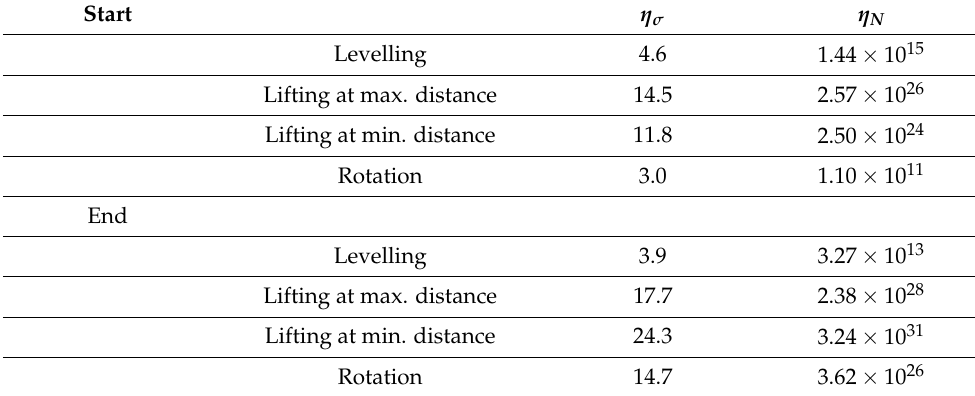
Table 12. Safety coefficient for the stick arm in the case of R = 0.1. Start η σ